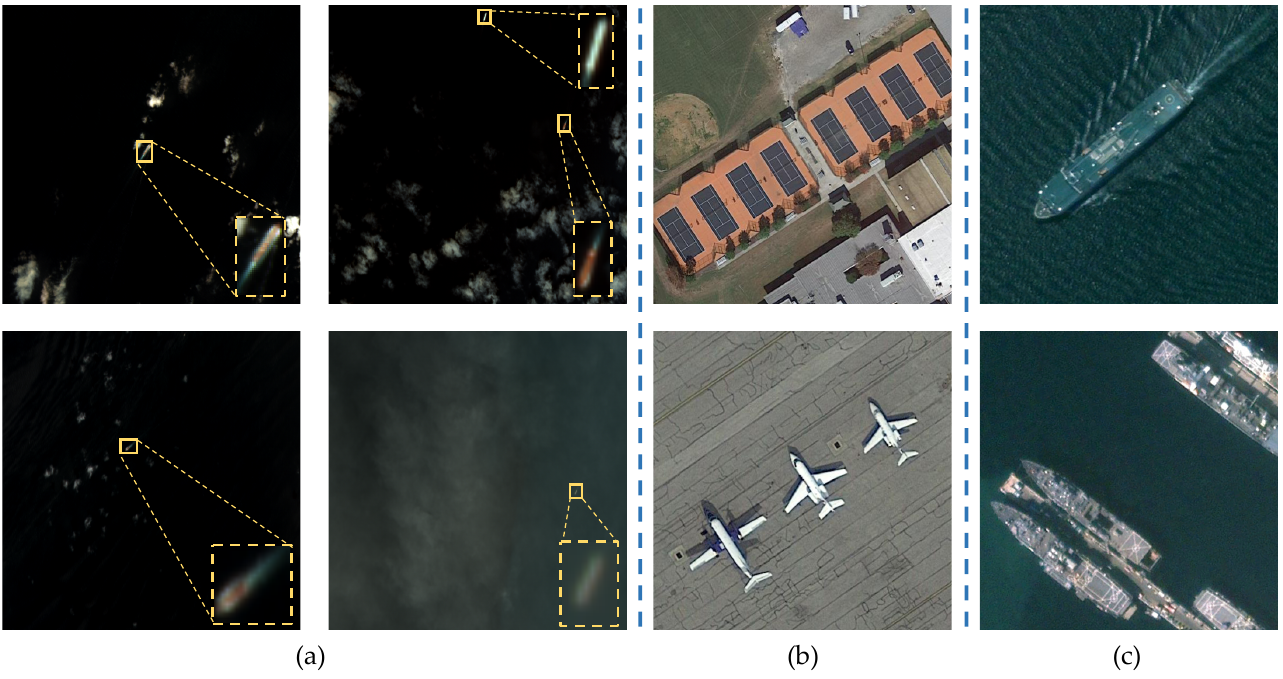
Figure 1. Image samples of different datasets, including ( a ) GF1-LRSD, ( b ) DOTA and ( c ) HRSC2016. For fair comparison, images have been cropped to the same size of 512 × 512. As can be seen, the objects in GF1-LRSD are significantly smaller than